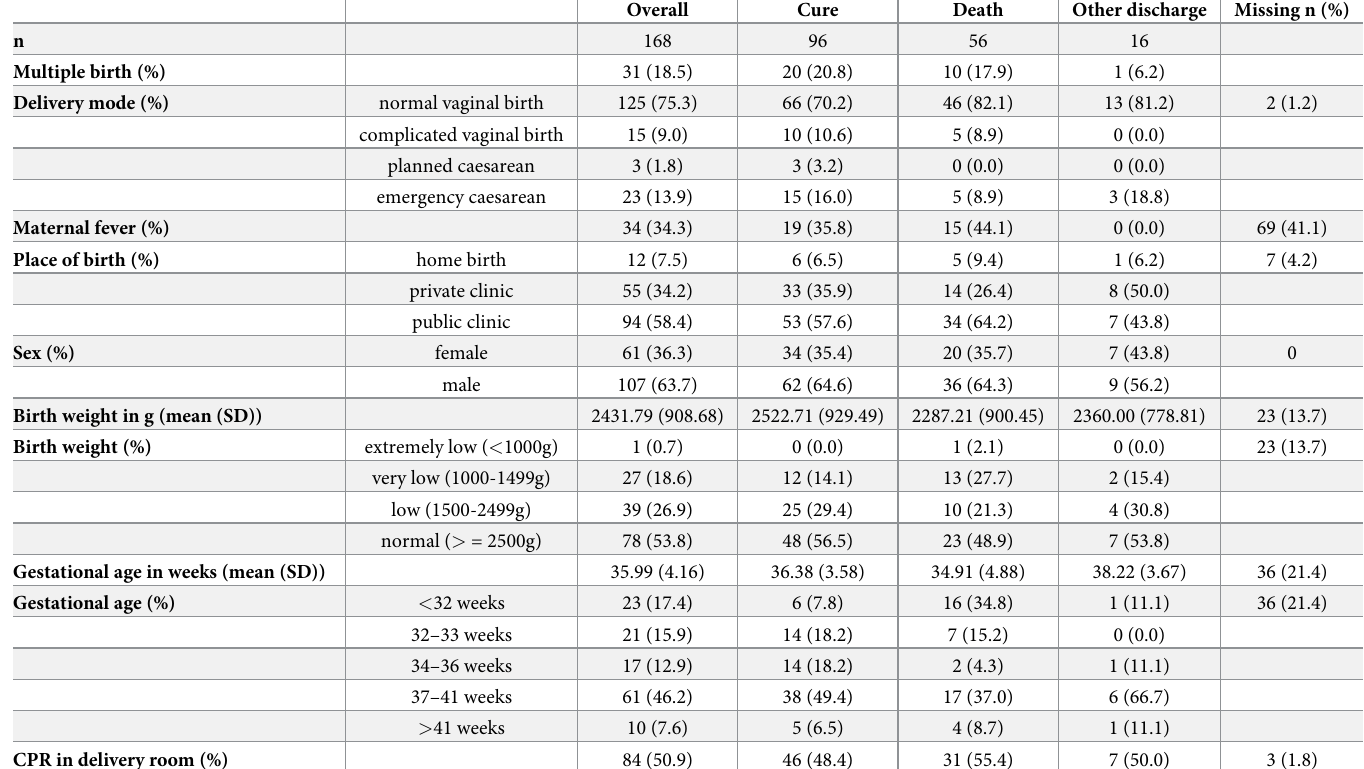
Table 4. The maternal obstetric and birth characteristics of newborns admitted to INSE, stratified by neonatal outcome (cure or death during hospital stay or other